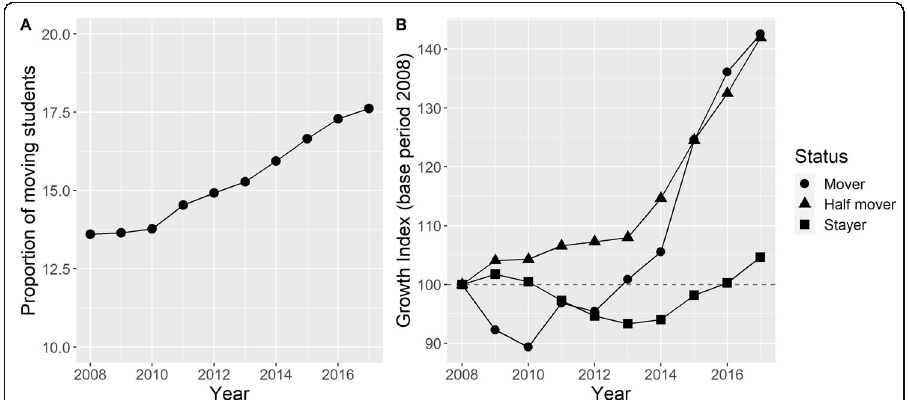
Fig. 2 Panel A , time series of mobility rates ( movers and half movers ) of northern first-year students. Panel B ,